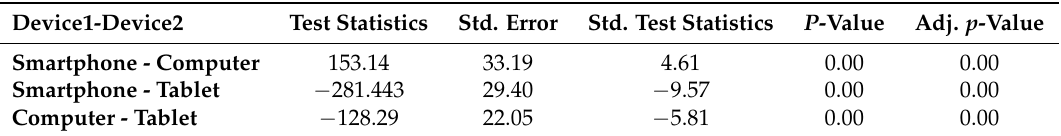
Figure 2. Statistical differences according to the Mann-Whitney test considering if there is any relation between accessing or not accessing the LMS and the number of failed subjects. The right side of the subfigures (in green color) represents the students who have logged into the LMS and the left side (blue color) represents the students who have not logged into the LMS. ( a ) Differences between the number of failed subjects for students accessing and not accessing the LMS considering all the educational stages. ( b ) Differences between the number of failed subjects for students accessing and not accessing the LMS considering the elementary stage. ( c ) Differences between the number of failed subjects for students accessing and not accessing the LMS considering the secondary stage. ( d ) Differences between the number of failed subjects for students accessing and not accessing the LMS considering the bachelor degree’s stage. Table 7. Values of the Kruskal-Wallis statistical test and the Bonferroni post-hoc test related to the differences between the number of passed subjects and the type of device used to access the